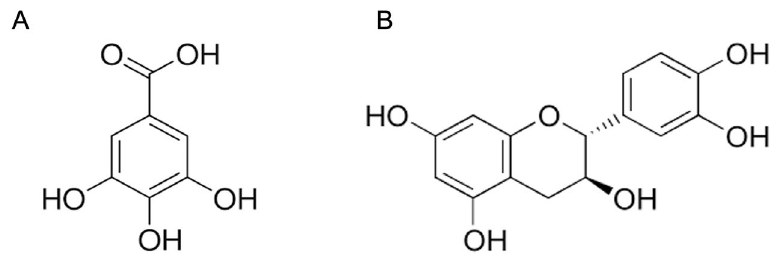
Figure 3. The chemical structures of ( A ) GA and ( B ) CH. GA, gallic acid; CH, catechin hydrate.